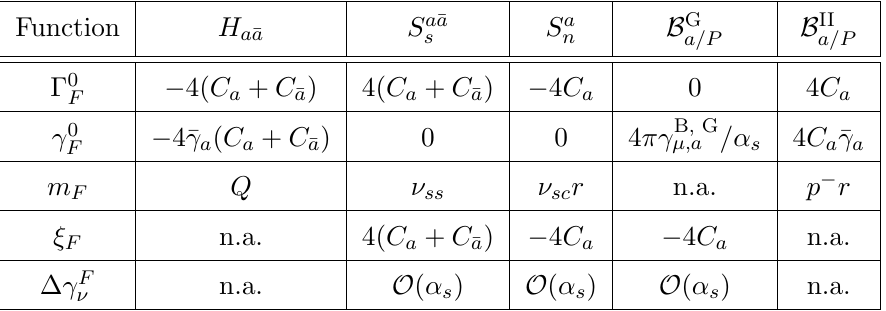
(cid:17) ) + (cid:22) (cid:13) . (cid:0) q